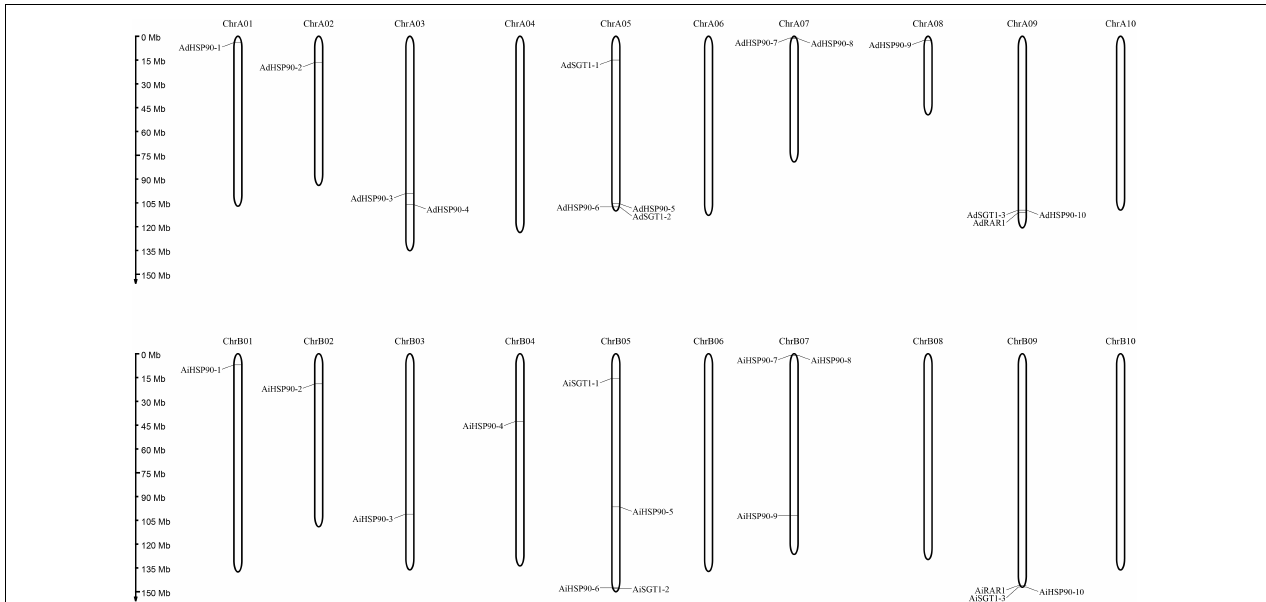
FIGURE 1 | Chromosomal locations of HRS-related genes in the A. duranensis and A. ipaensis genomes. The chromosome numbers are shown at the top of each chromosome (black bars). The left side of each chromosome corresponds to the approximate location of each HRS-related